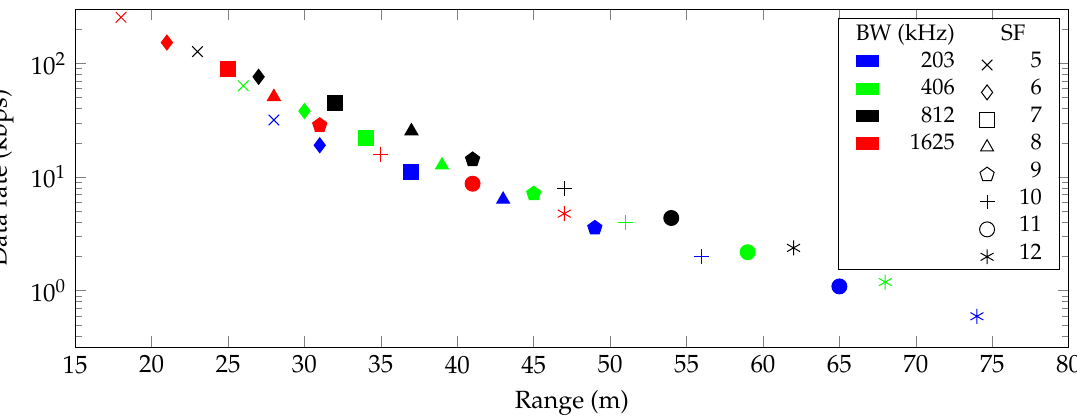
Figure 3. Communication range and data rate for every combination of spreading factor (SF) and bandwidth (BW) in an indoor